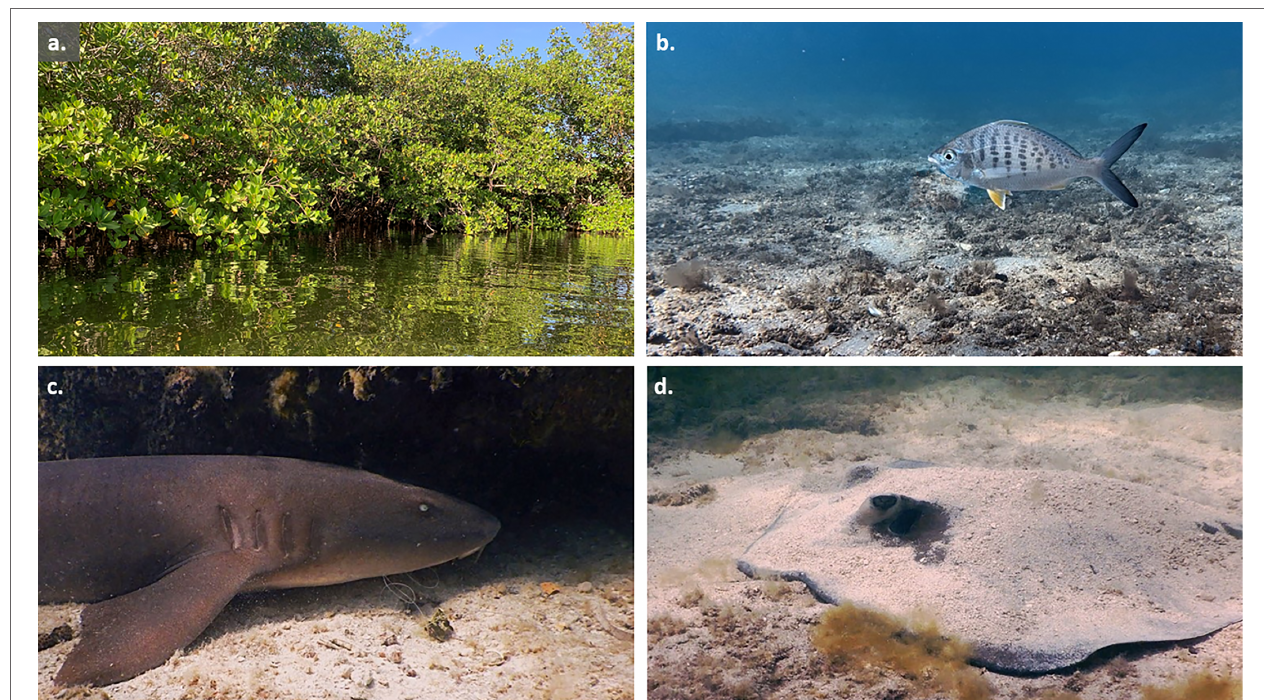
FIGURE 2 | (A) The mangrove shoreline as seen from site Alt 5, photo credit Ellery Lennon. (B) Gerres cinereus were among the most abundant fish seen in the IBBEAM surveys, photo credit Ellery Lennon. (C) Ginglymostoma cirratum , photo credit Maria Laukaitis, and (D) Hypanus americanus , photo credit Kathleen Sullivan Sealey, were among the least abundant fish seen during the IBBEAM